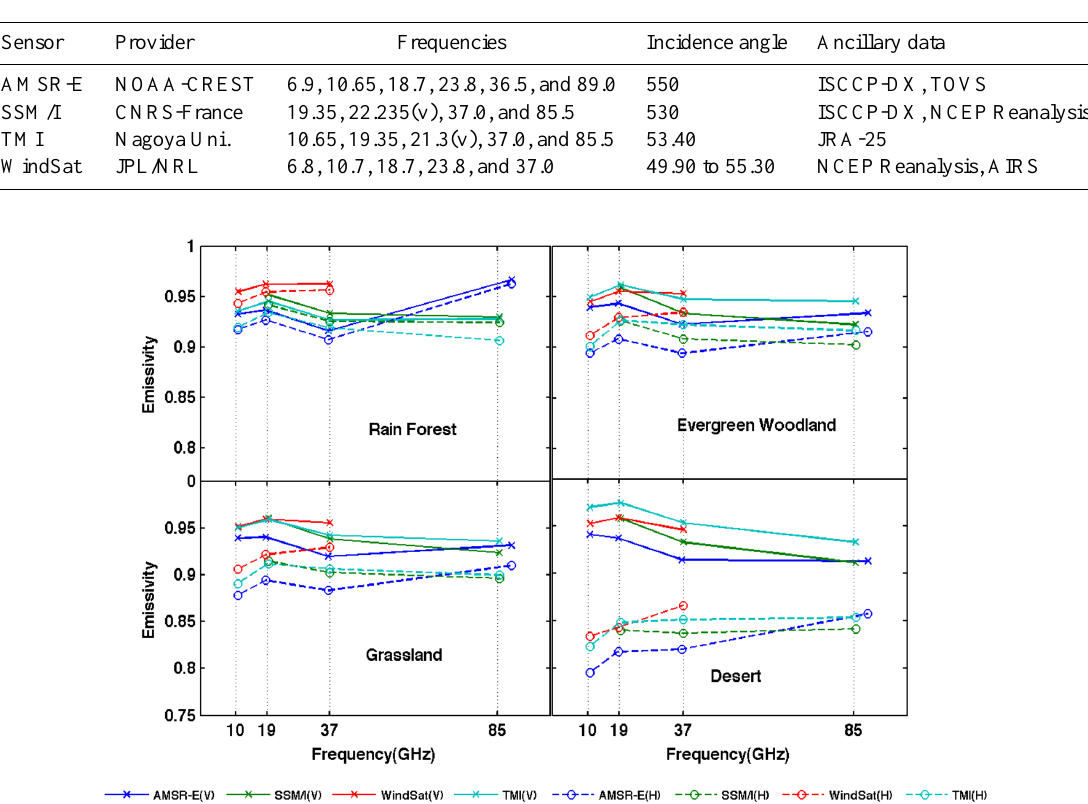
Figure 1. Mean of monthly emissivity values (from 2003 to 2007) for rain forest, evergreen woodland, grassland, and desert regions on a global scale from AMSR-E, TMI, SSM/I, and WindSat. The solid lines present vertical polarization, and dashed lines are for horizontal